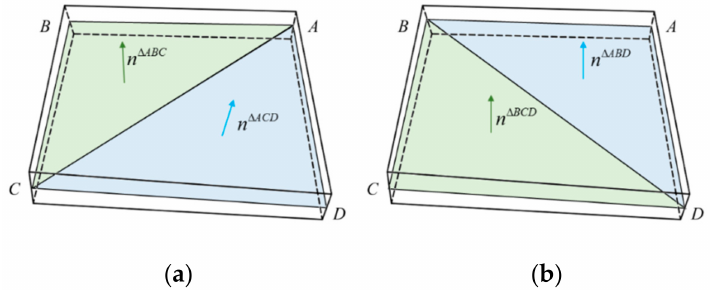
Figure 3. Definition of the warping angle. ( a ) ϑ AC is the angle between n ∆ ABC and n ∆ ACD ( b ) ϑ BD is the angle between n ∆ ABD and n ∆ BCD